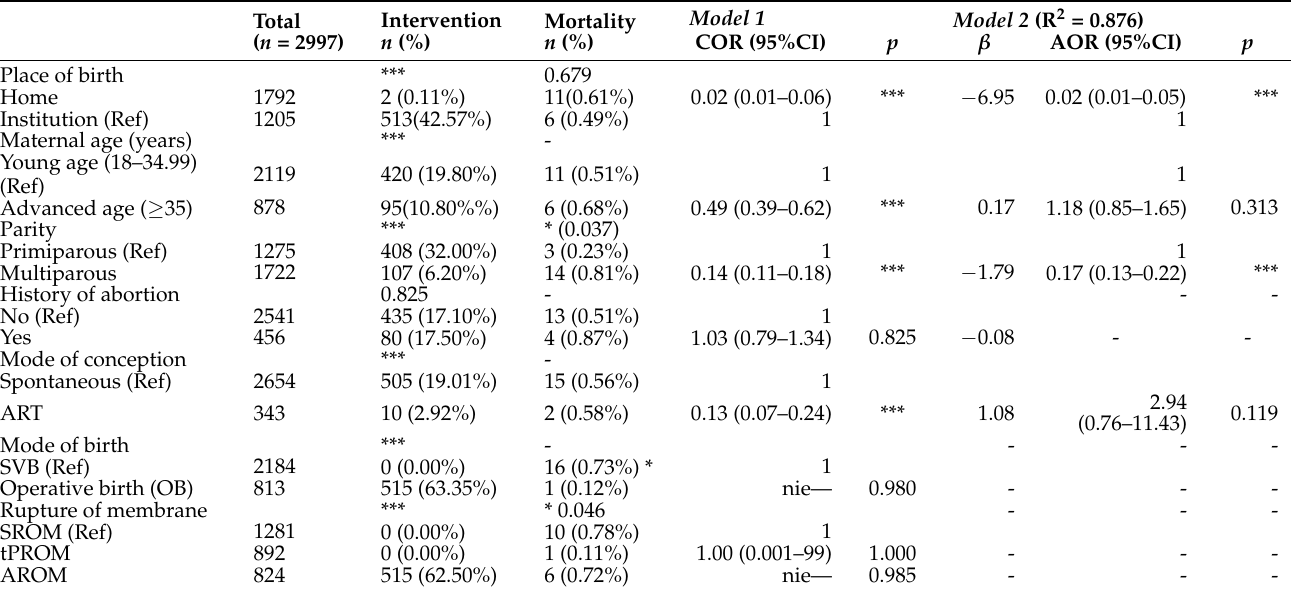
Table 4. Summary statistics of women and feto-neonatal home and institutional birth characteristics and outcomes: Pooled risk measures (Intervention (C/s and AROM) * Perinatal mortality); using intention-to-treat-like approach and case-mix